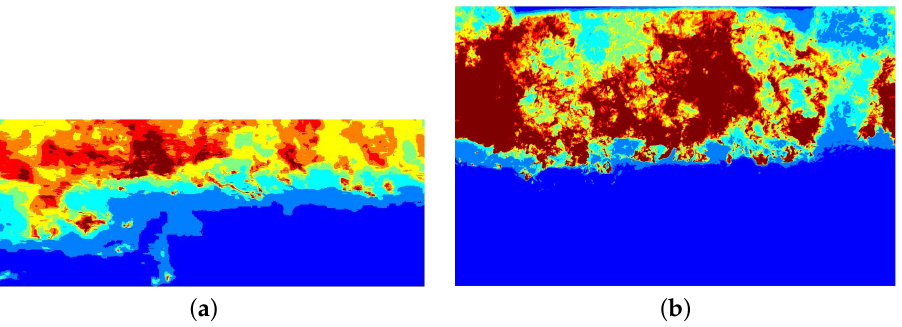
Figure 10. Innermost zone of Flame Location. ( a ) Innermost zone of Flame Location of Source Image; ( b ) Innermost zone of Flame Location of Reference